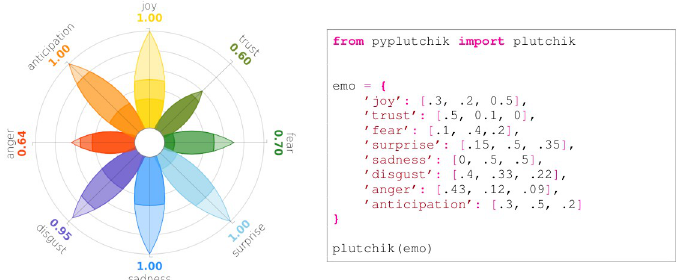
Fig 5. Plutchik’s wheel generated by code on the right. Each entry in the Python dict is a three-sized array, whose sum must be 2 [0, 1].